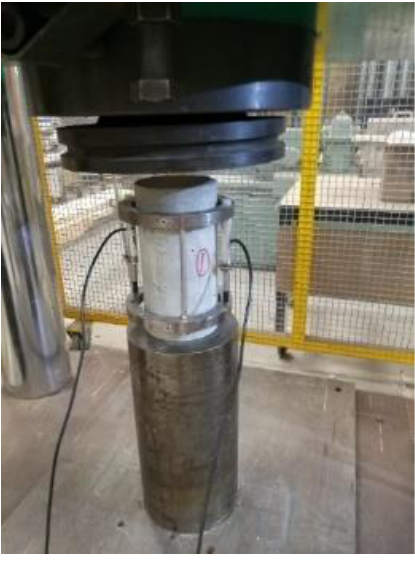
Figure 8. Test device for measuring the compressive stress – strain curve of control mortar.